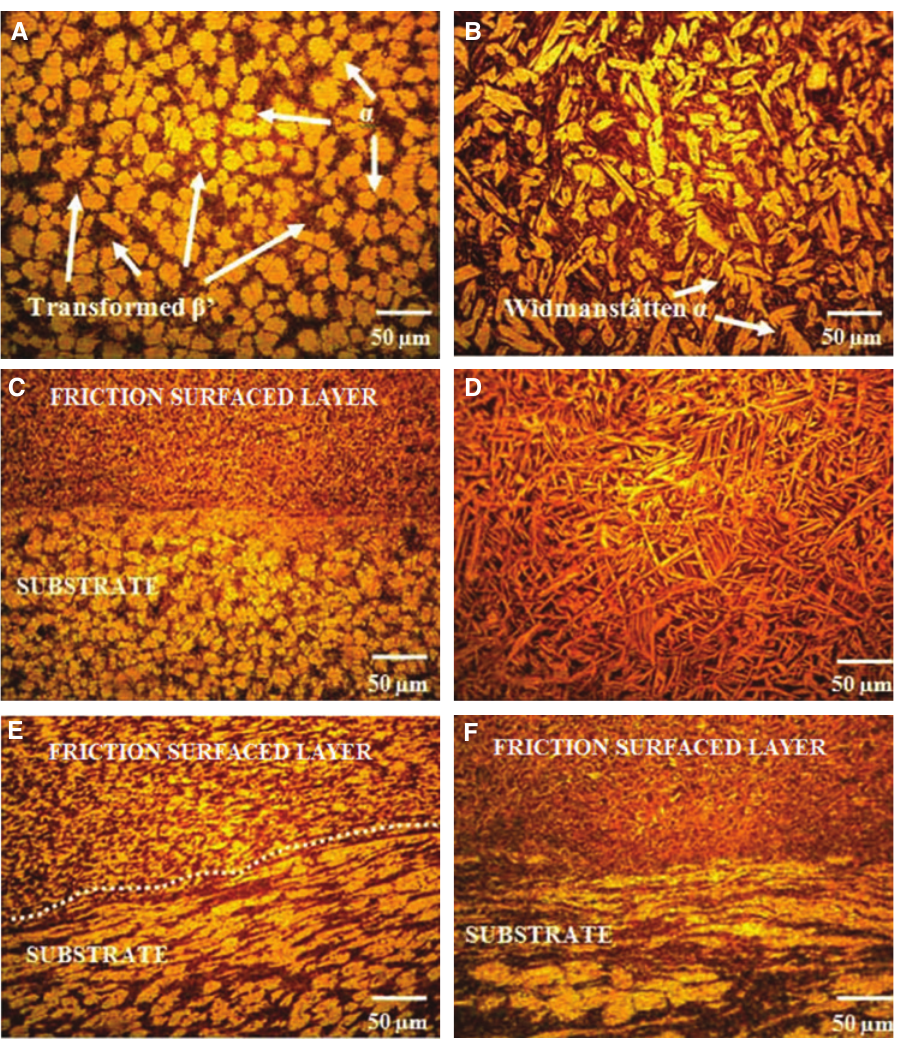
Figure 5: Optical microstructures of substrate, mechtrode and friction surfaced interfaces. (A) Base material-cast NAB, (B) mechtrode-extruded NAB, (C) interface-friction surfacing and substrate, (D) unmixed friction surfacing, (E) interface-friction surfacing and substrate, (F) interface-friction surfacing and substrate ( α grains and β